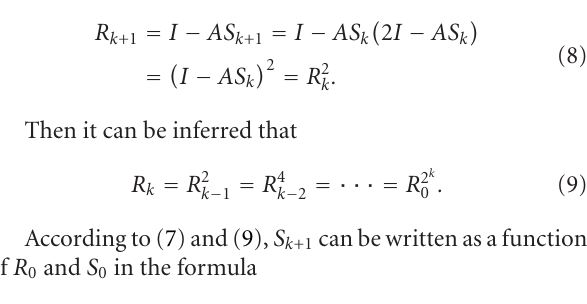
Figure 1: An illustration of system geometry. The excited sources and detectors are posed alternately around the circle of 50mm di- ameter with equal intervals between each other. The power of the incident sources is 3 mw each.The reconstructed area is the central square slab of 0.1 cm thickness with each side of 32 mm. The solid lines represent the positions of the excited sources and the dotted lines represent the